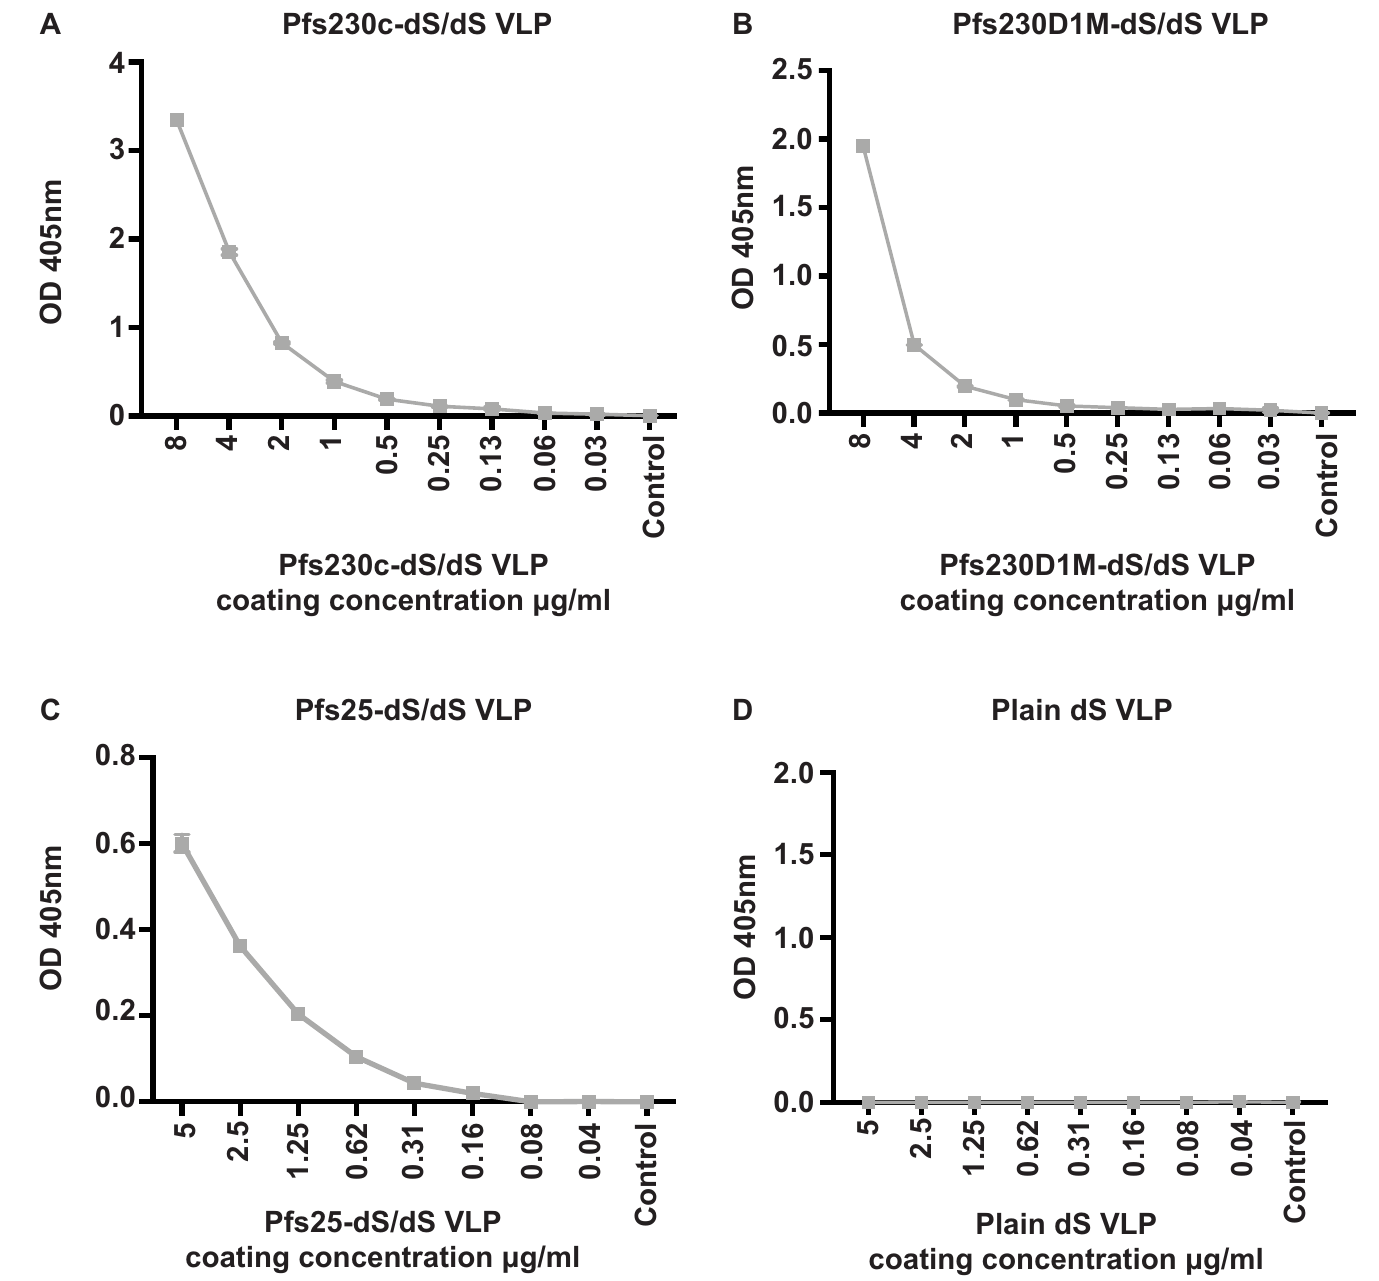
Fig 1. Characterising the expression of sexual-stage antigens on chimeric VLPs. Total antibody binding to ( A ) Pfs230c-dS/dS, ( B ) Pfs230D1M-dS/dS, ( C ) Pfs25-dS/ dS and ( D ) plain dS VLPs were measured by ELISA. VLPs were coated at varying concentrations ( μ g/ml) and probed with either a Pfs25 or Pfs230-specific polyclonal antibody (1 μ g/ml). In ( D ), plain dS VLPs were probed with anti-Pfs230 antibody. The level of antibody binding is expressed as optical density (OD) measured at 405nm; symbols represent the mean and error bars represent the range between samples tested in duplicate.